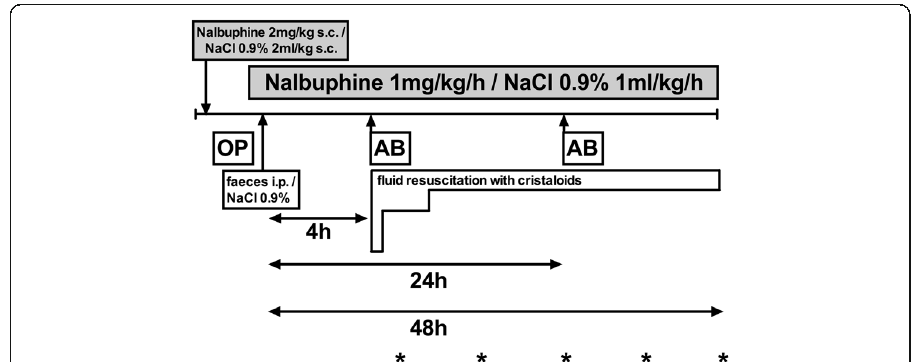
Fig. 3 Design of long-term experiments. Animals underwent either faecal peritonitis or sham (NaCl 0.9%) i.p. injection and were subsequently randomized to either nalbuphine (1 mg/kg/h) or placebo (NaCl 0.9% 1 ml/kg/h) infusion. Asterisks indicate frequency of clinical scoring (6, 12, 24, 36, and 48 h). AB: antibiotics (ceftriaxone, 30 mg/ kg i.v.); OP operation (=instrumentation). The subcutaneous administration of nalbuphine in combination